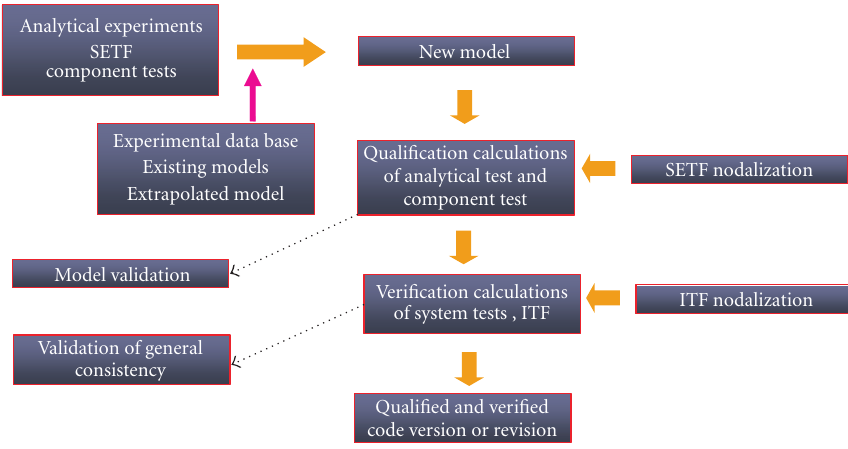
Figure 5: Qualification process of a new revision or a new version of the